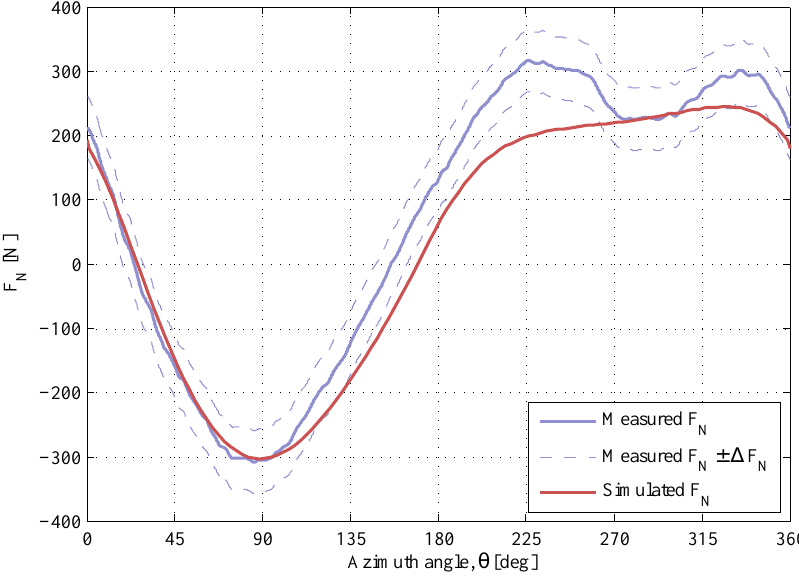
Figure 17. The normal force at λ = 4 . 57 , Ω = 65 . 35 rpm . The air density and the kinematic viscosity are ρ = 1 . 25 kg / m 3 and ν = 1 . 43 · 10 − 5 m 2 / s